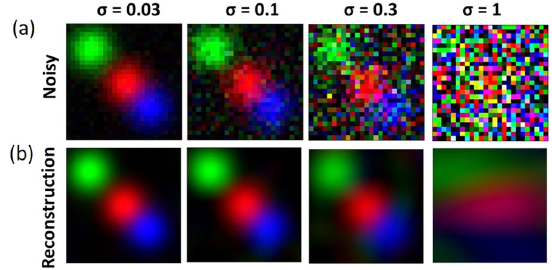
Fig. 6 Multivariate GP reconstruction of synthetic data. Data (top row) and multivariate GP reconstruction (bottom row) for several noise levels. The vertical scale is [0, 1] for all RGB components. The reconstructed images are resampled on a four times denser